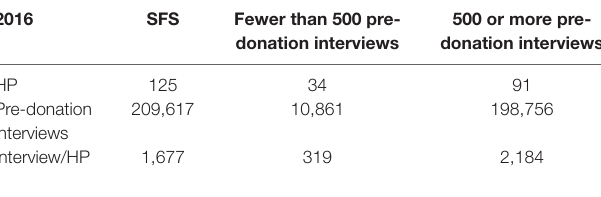
TaBle 1 | Activity of health professionals (HPs).